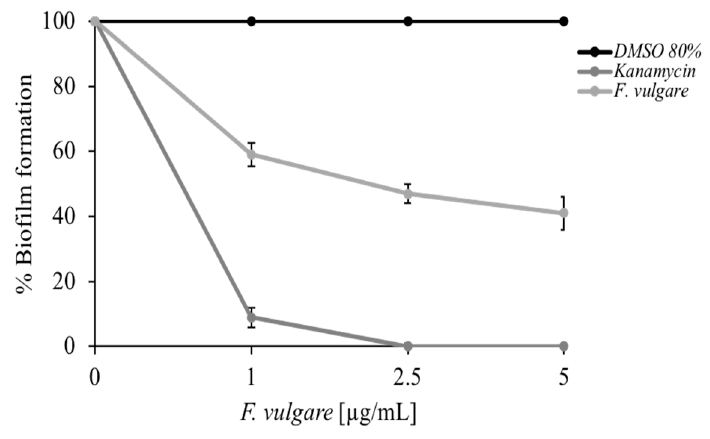
Figure 5. Colorimetric assay to evaluate the % of biofilm formation of M. smegmatis , at different concentrations of F. vulgare subsp. vulgare var. vulgare EO (1, 2.5, 5 µ g/mL). The negative control is represented by DMSO (80%) and the positive control by Kanamycin. The assays were performed in three biological replicates; standard deviations are always less than 10%.